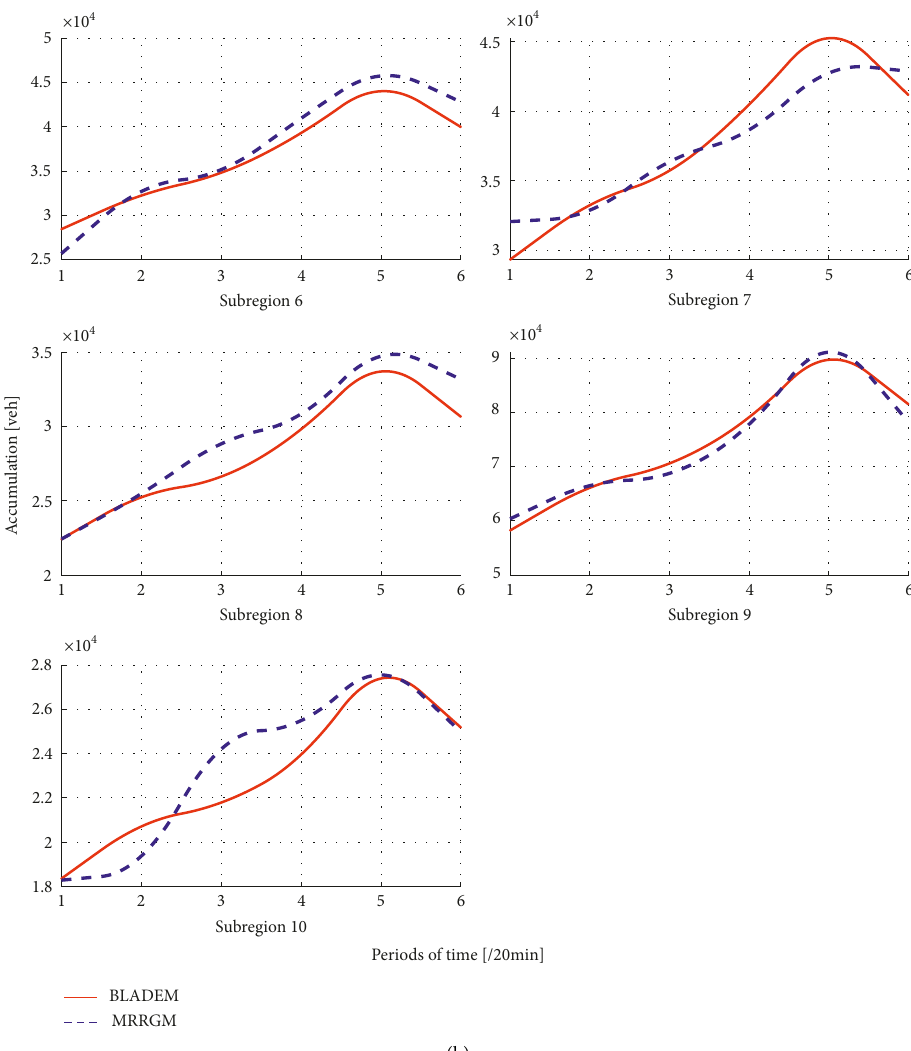
Figure 11: The accumulation curve in sub-region. (a) Subregion 1 ∼ 5. (b) Subregion 6 ∼